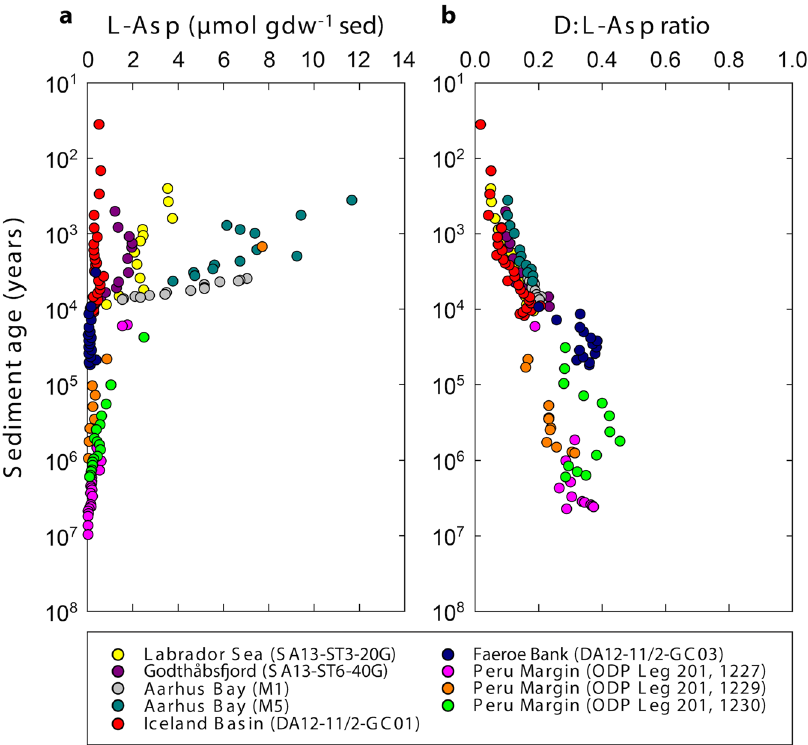
Figure 4. Occurrence of L-Asp and D:L-Asp ratios. ( a ) Total concentrations of L-Asp. ( b ) D:L-Asp ratios increase with age of the sediment. The unit ‘per gram dry weight sediment’ is abbreviated with ‘gdw − 1 sed’. Note that sediment ages are on logarithmic